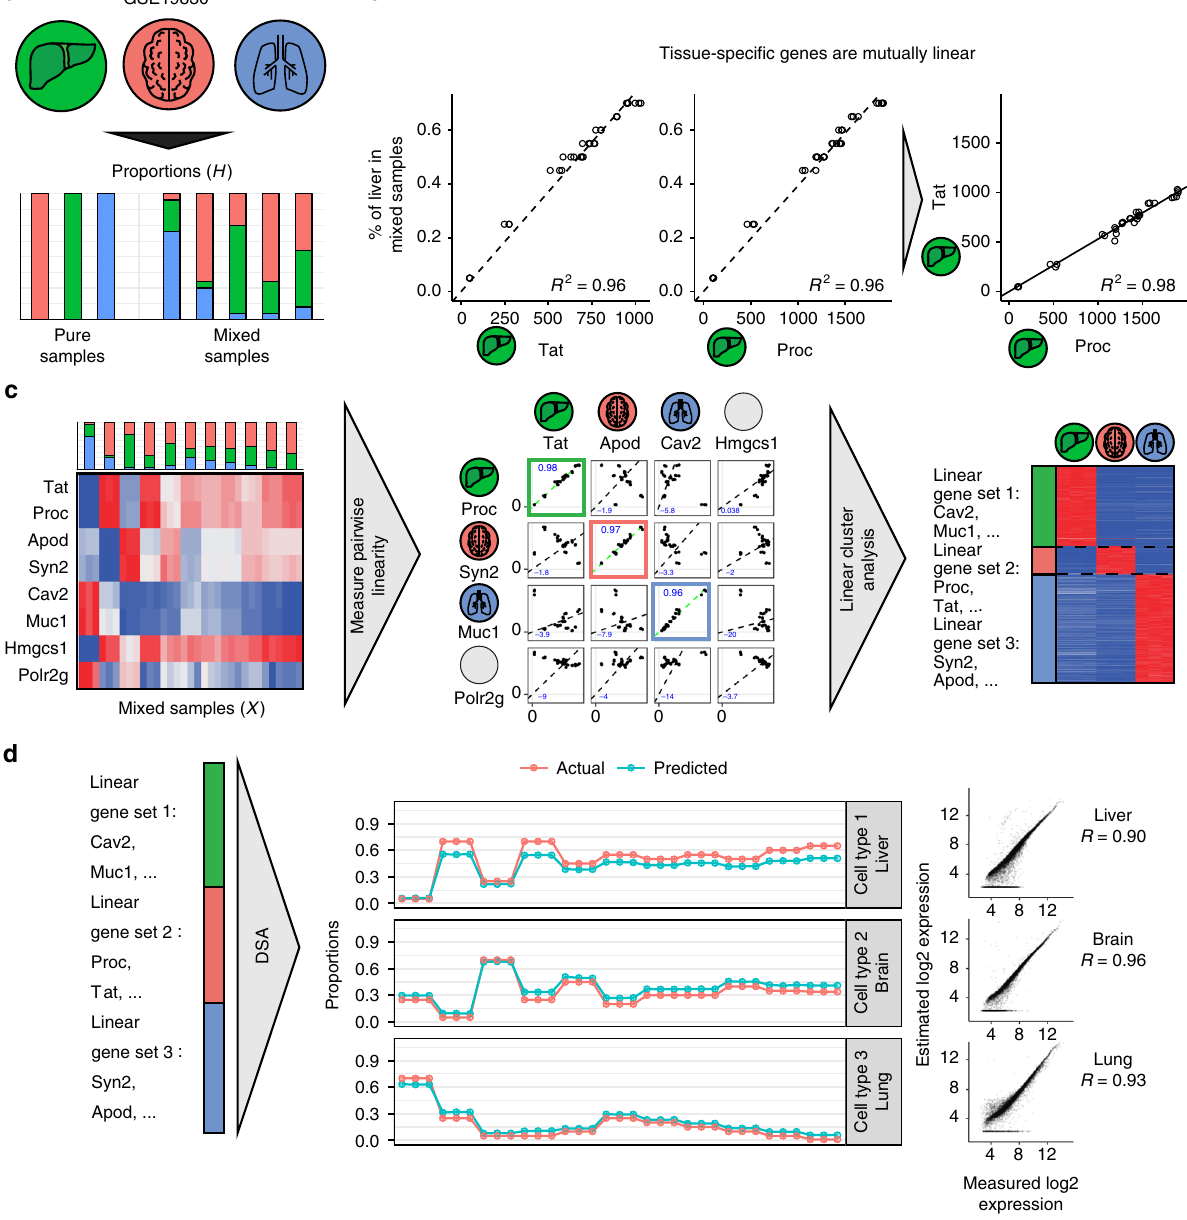
Fig. 1 Mutual linearity of cell-type-speci fi c genes enables complete deconvolution. a Design of gene expression dataset GSE19830. RNA from three different rat tissues: kidney, brain, and liver were mixed together in known proportions. Gene expression data for pure and mixed samples were measured via microarray pro fi ling. b Linear regression without intercept between % of liver and Tat/Proc expression (left), linear regression between Tat and Proc (right). R ² is coef fi cient of determination. c Approach schematics: given a gene expression matrix of mixed samples as an input we then measured pairwise similarities for each pair of genes and then identi fi ed clusters of mutually linear genes. Heatmap on the left shows expression of identi fi ed genes in pure tissues from 0 (blue) to gene max (red). d Left: Identi fi ed gene sets used as DSA algorithm input. Middle: estimated and actual fractions. Right: comparison of estimated and actual gene expression signatures. R is Pearson